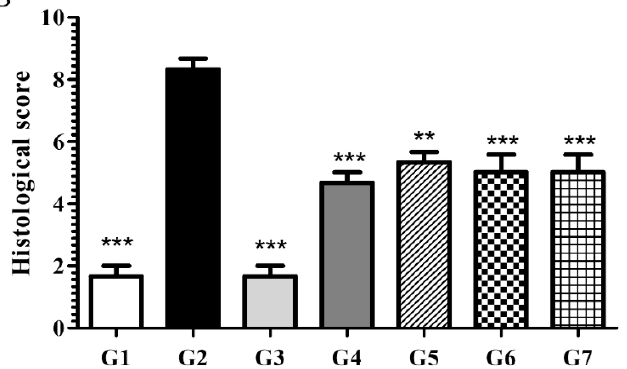
Figure 2. Effect of phytoncide treatment on histological changes in indomethacin-induced gastric damage. ( A ) Results of the H&E staining, × 100 magnification. ( B ) Effect of phytoncide on histological scores of the indomethacin-induced gastric ulcer. G1, normal control; G2, vehicle control (gastric ulcer control, indomethacin 80 mg/kg); G3, positive control (lansoprazole 30 mg/kg); G4, phytoncide oil 10 mL/kg; G5, phytoncide oil 5 mL/kg; G6, pine cone water extract 10 mL/kg; G7, pine cone water extract 5 mL/kg. Representative data are expressed as mean ± SEM of experiments ( n = 10) for each group. ** p < 0.01 and *** p < 0.001 compared to vehicle control.